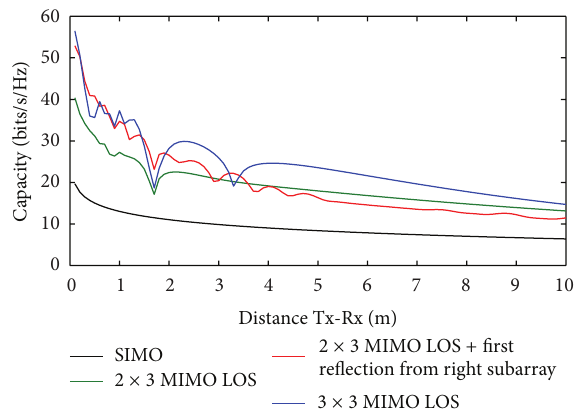
Figure 9: Indoor capacity for a moving